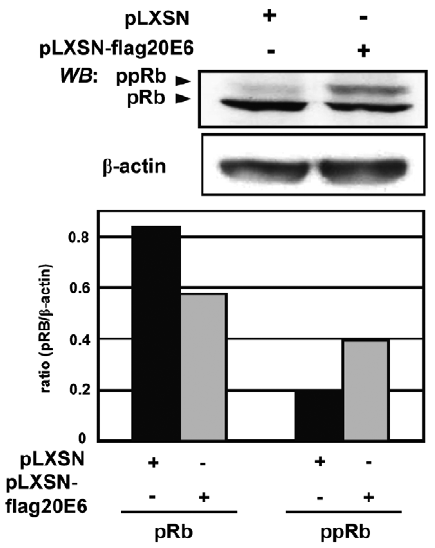
Figure 8. HPV20E6 increases the expression of ppRB. Western blot analyses of the protein level of pRb and ppRb in pLXSN-flag20E6 and pLXSN transduced NIKS cells. The pRb and ppRb protein level were quantified by Imagequant. Histograms were adjusted for b -actin which was used as a loading control.